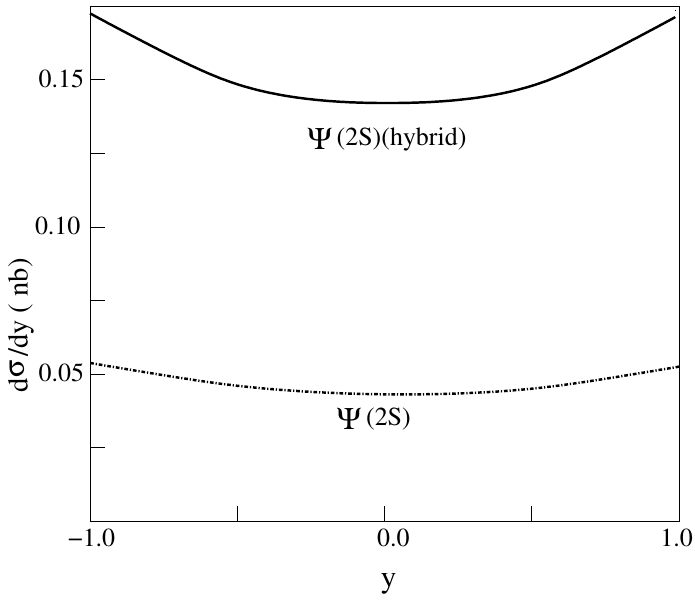
Figure 1 . d (cid:27) /dy for 2m=3 GeV,